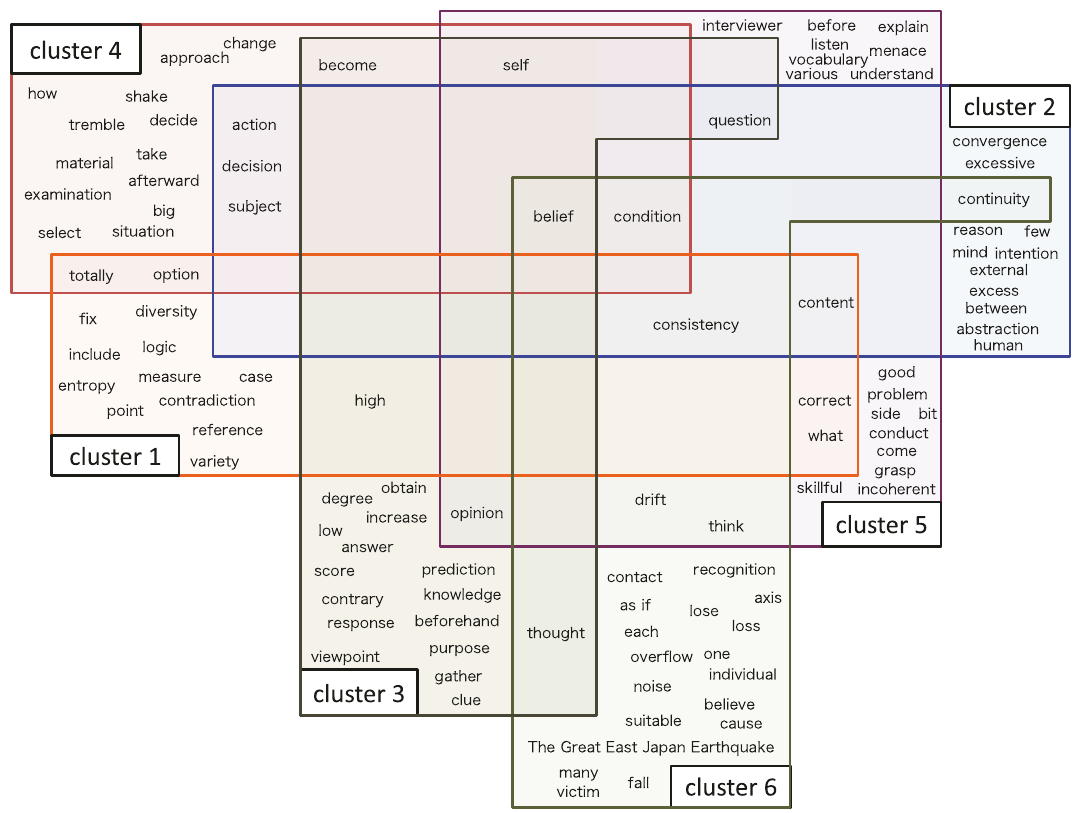
Figure 5: The clustering of terms in sentences about Belief Drift.